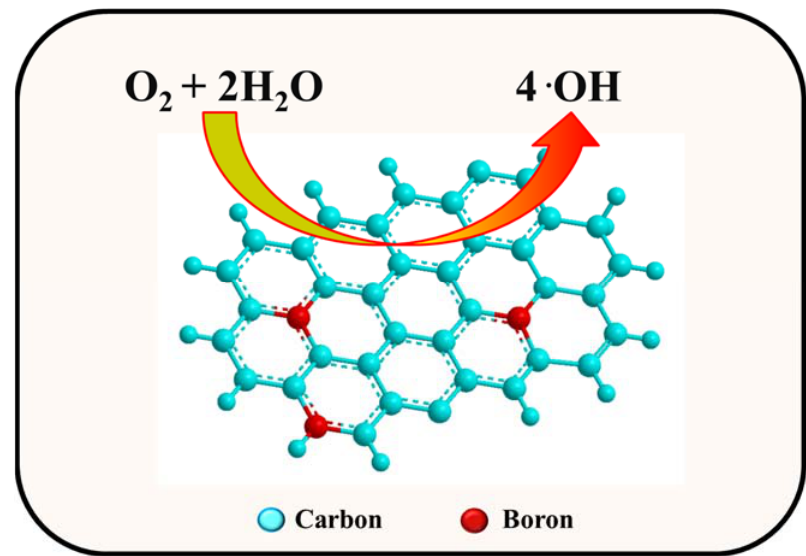
Figure 7. Illustration of electron transfer for ORR on the P-GNS surface.